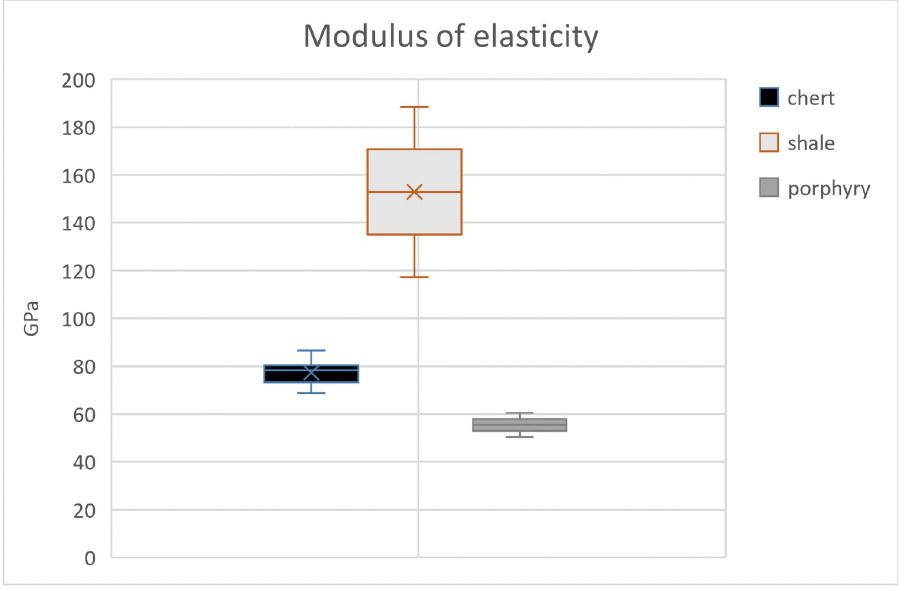
Fig 4. The boxplot illustrates the modulus of elasticity; values show that shale is less stiff than porphyry and